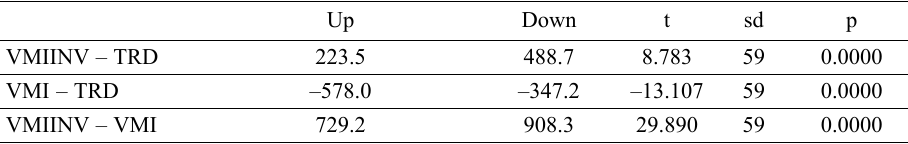
Table 8. Paired comparisons for the profit of the